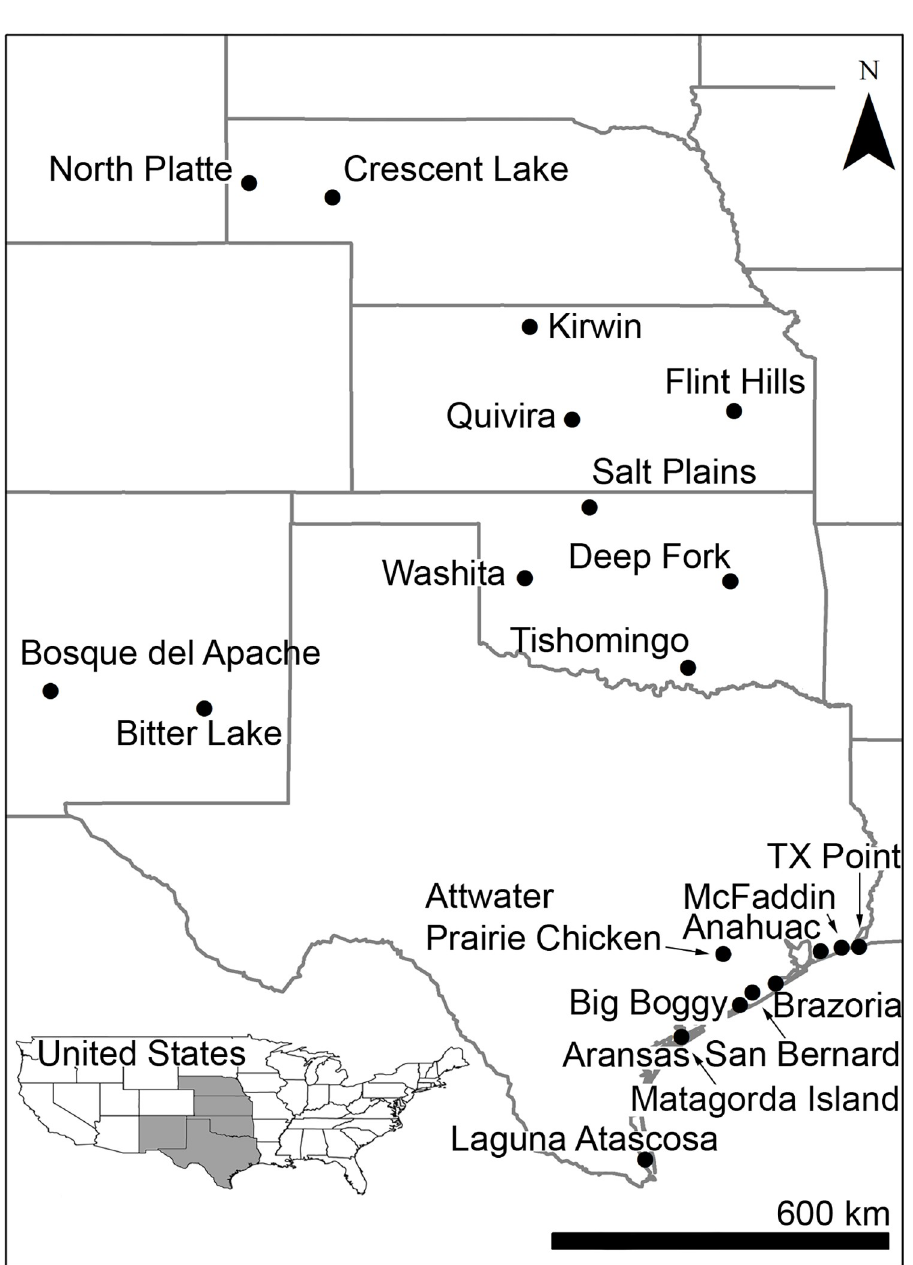
Fig 1. Locations of the National Wildlife Refuges included in this study. Abbreviation represents Texas Point (TX Point).